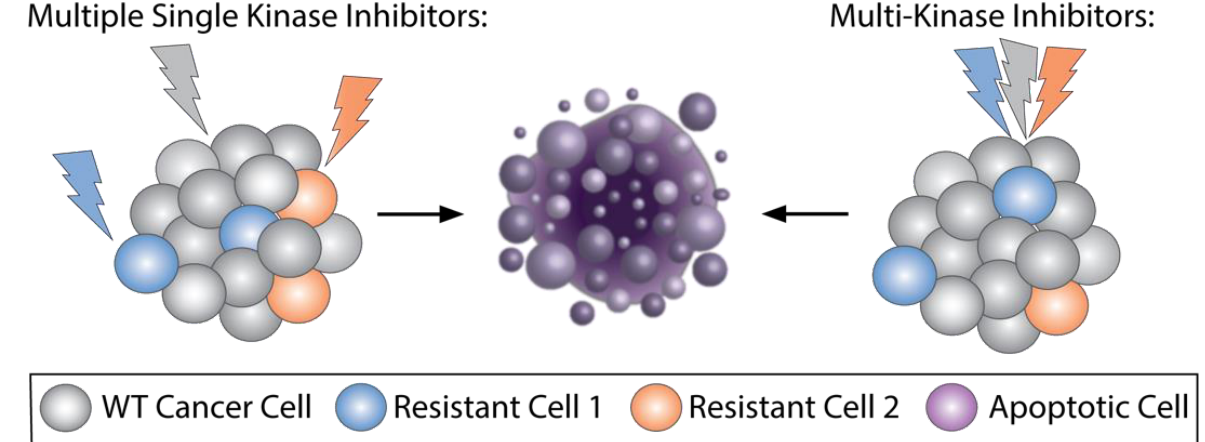
Figure 2. Hitting multiple targets at once to overcome resistance. Since resistance to targeted therapies can occur from residual tumor cells that are not eradicated selective single kinase inhibitors, multiple kinase targeted therapies can be utilized to overcome resistance. Using two or more single kinase selective agents (left) or multikinase inhibitor single agents (right) can target driver mutations and potential escape mechanisms simultaneously and obviate need for multiple sequential therapies.